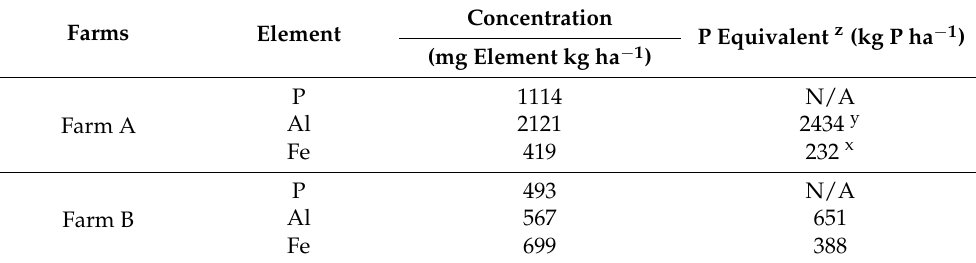
Table 7. Soil Mehlich-3 extractable P, Al, and Fe for Farm A and B in 2020. Farms